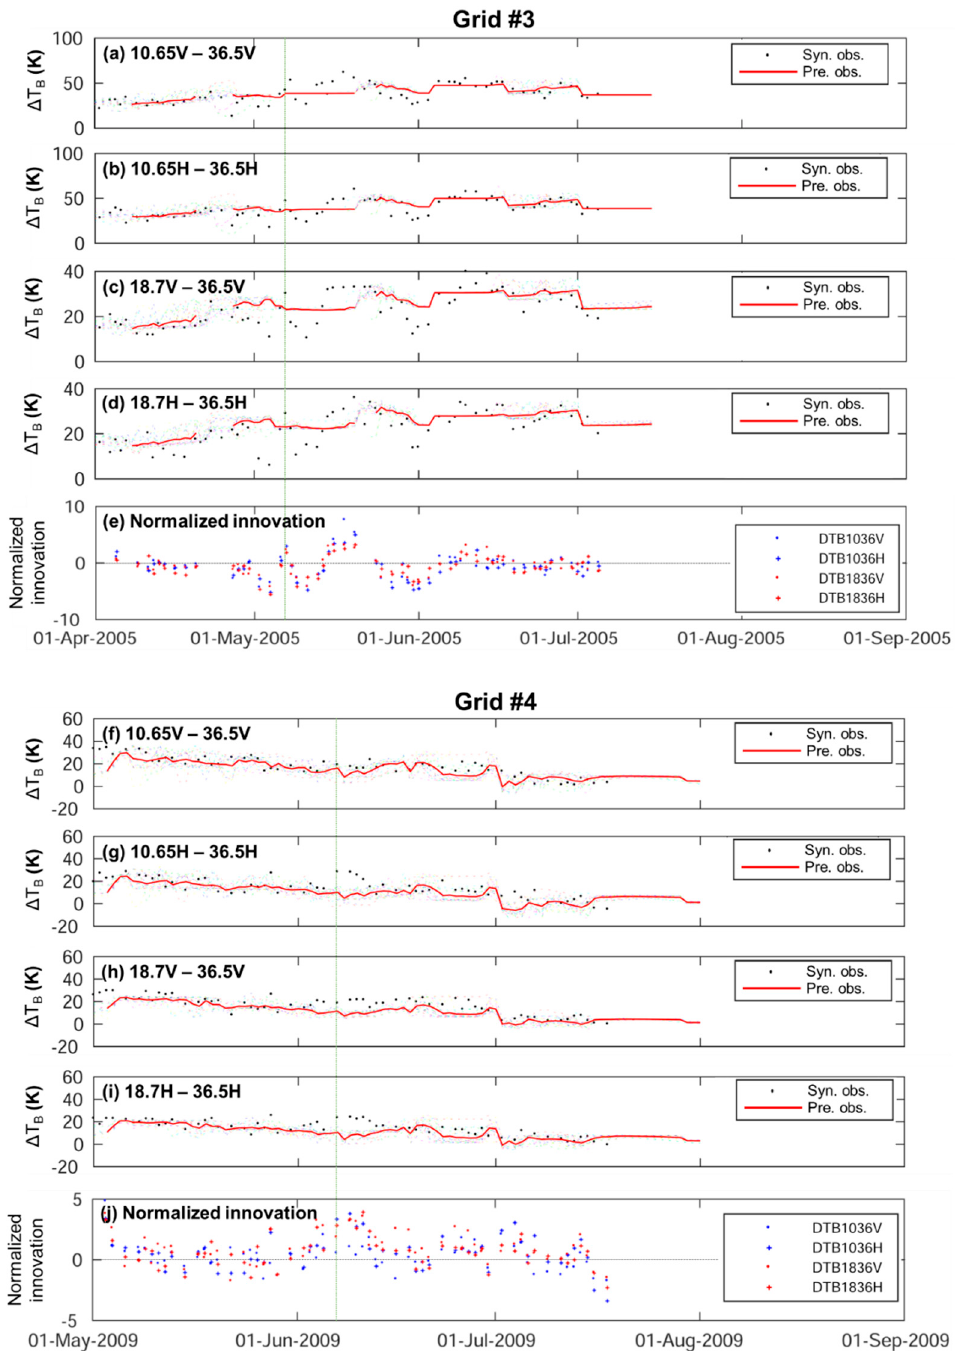
Figure 7. Time series of synthetic Δ T B observations (black dots) and the predicted prior Δ T B (red line) for Grid #3 and Grid #4: 10.65 V–36.5 V ( a , f ), 10.65 H–36.5 H ( b , g ), 18.7 V–36.5 V ( c , h ), and 18.7 H–36.5 H ( d , i ). The solid and dotted lines denote the ensemble mean and range of the predicted prior Δ T B , respectively. The normalized innovation sequence is plotted in ( e , j ).